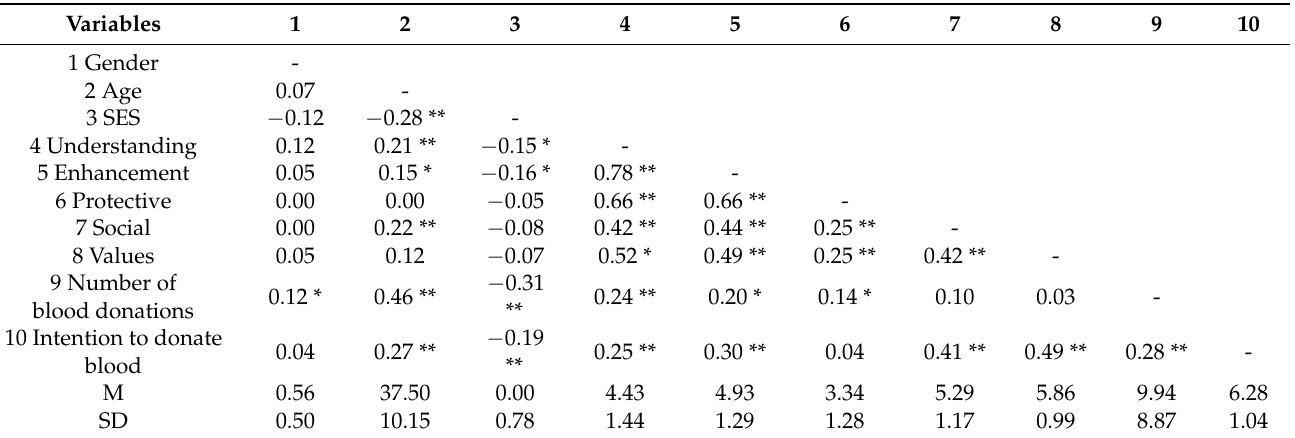
Table 1. Means, standard deviations, and correlations coefficients of the main variables 1